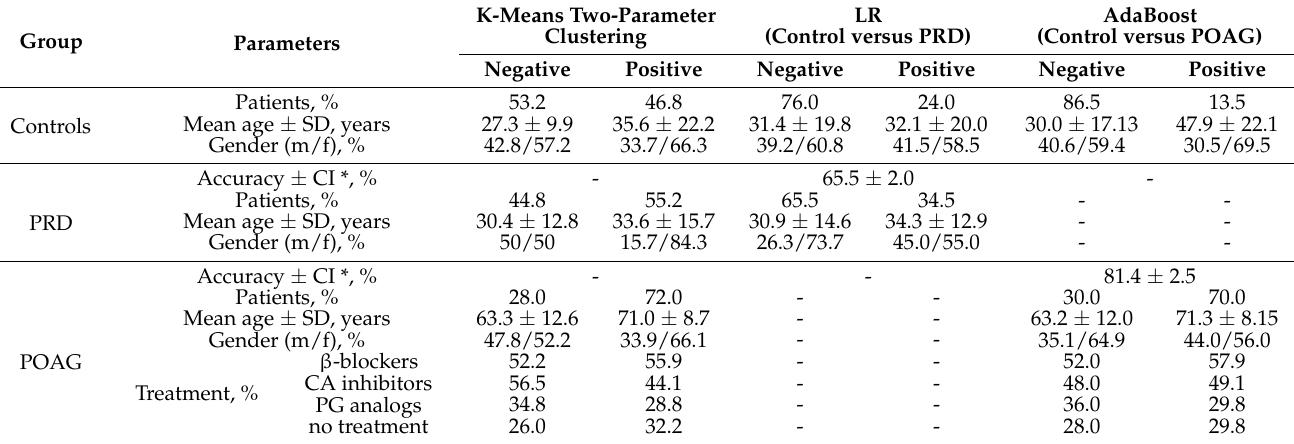
Table 2. Distribution of patients in groups determined by the different classifying